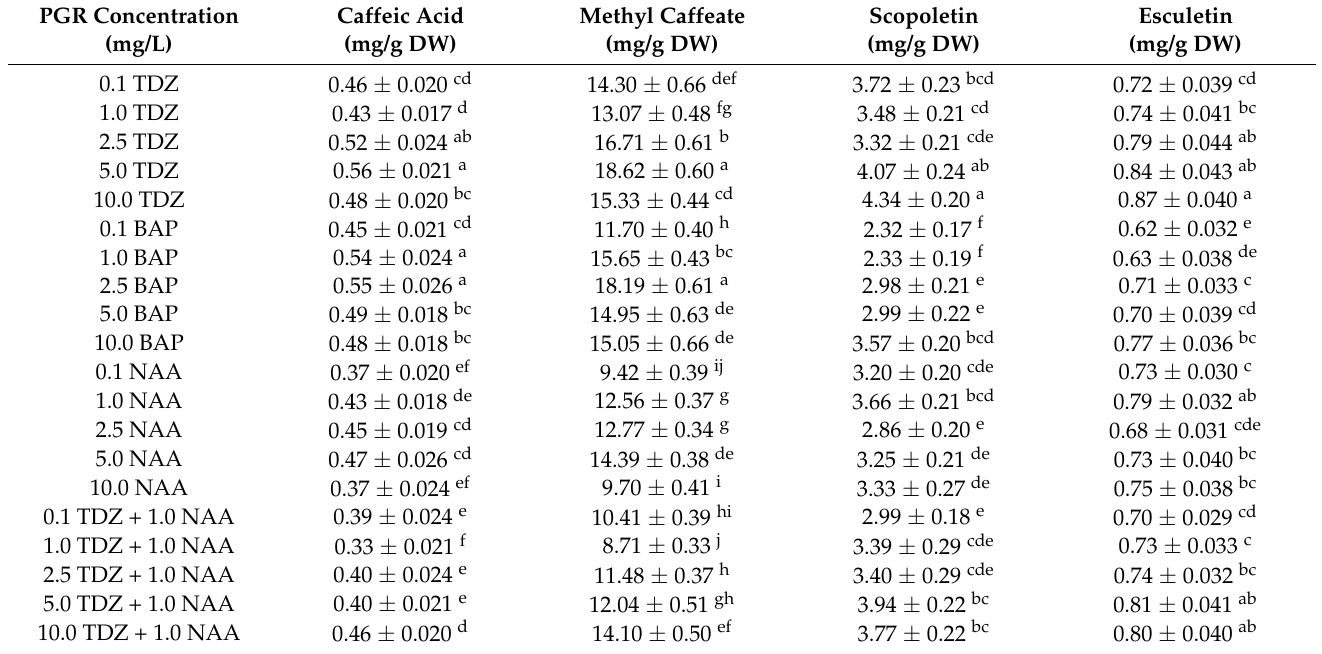
Table 3. Phytochemical analyses of extracts from treated S. virginianum callus